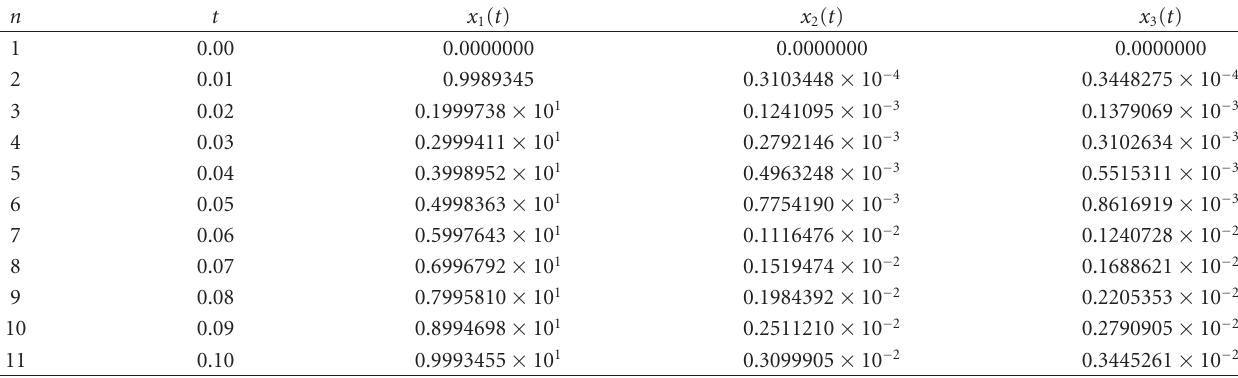
Table 2: Result for impulse model.